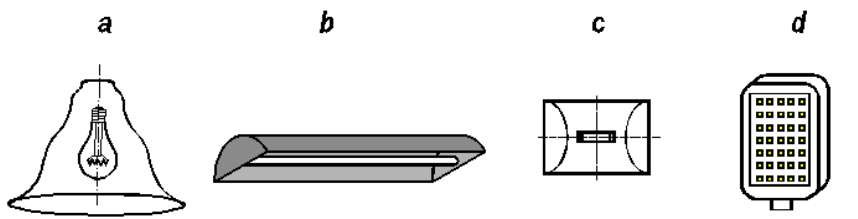
Figure 1. Typical designs of the luminaires for various types of light sources: ( a ) incandescent, ( b ) fluorescent, ( c ) discharge, ( d ) LED.